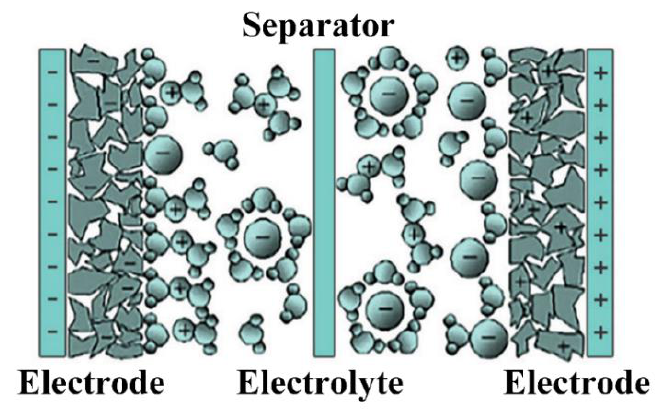
Figure 15. Schematic view of an individual cell of a supercapacitor; under an electric field, the electrolyte acts as the dielectric and the electrodes are made of carbon nanotubes (CNT) [37,55,56].